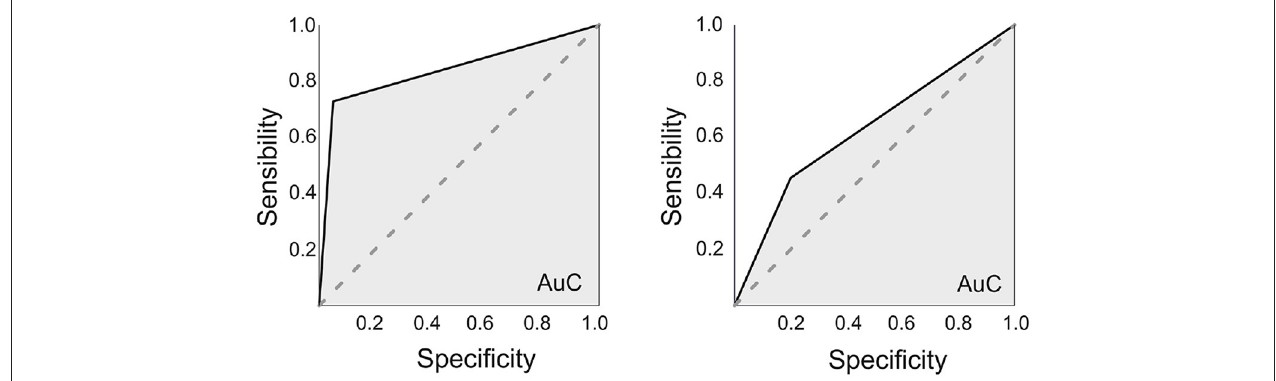
FIGURE 5 | ROC curves. On the left, using the anterior/posterior division of the hippocampi (Connectivity measures for the Posterior bilateral hippocampi-DMN and the anterior to-be resected hippocampus-DAN). The area under the curve (AuC) was of 0.835, with an optimal sensitivity of 0.727 and specificity of 0.95. On the right, using the whole hippocampus (also connectivity measures from the bilateral hippocampi-DMN and the to-be resected hippocampus-DAN). The AuC was 0.63, with an optimal sensitivity of 0.46 and specificity of